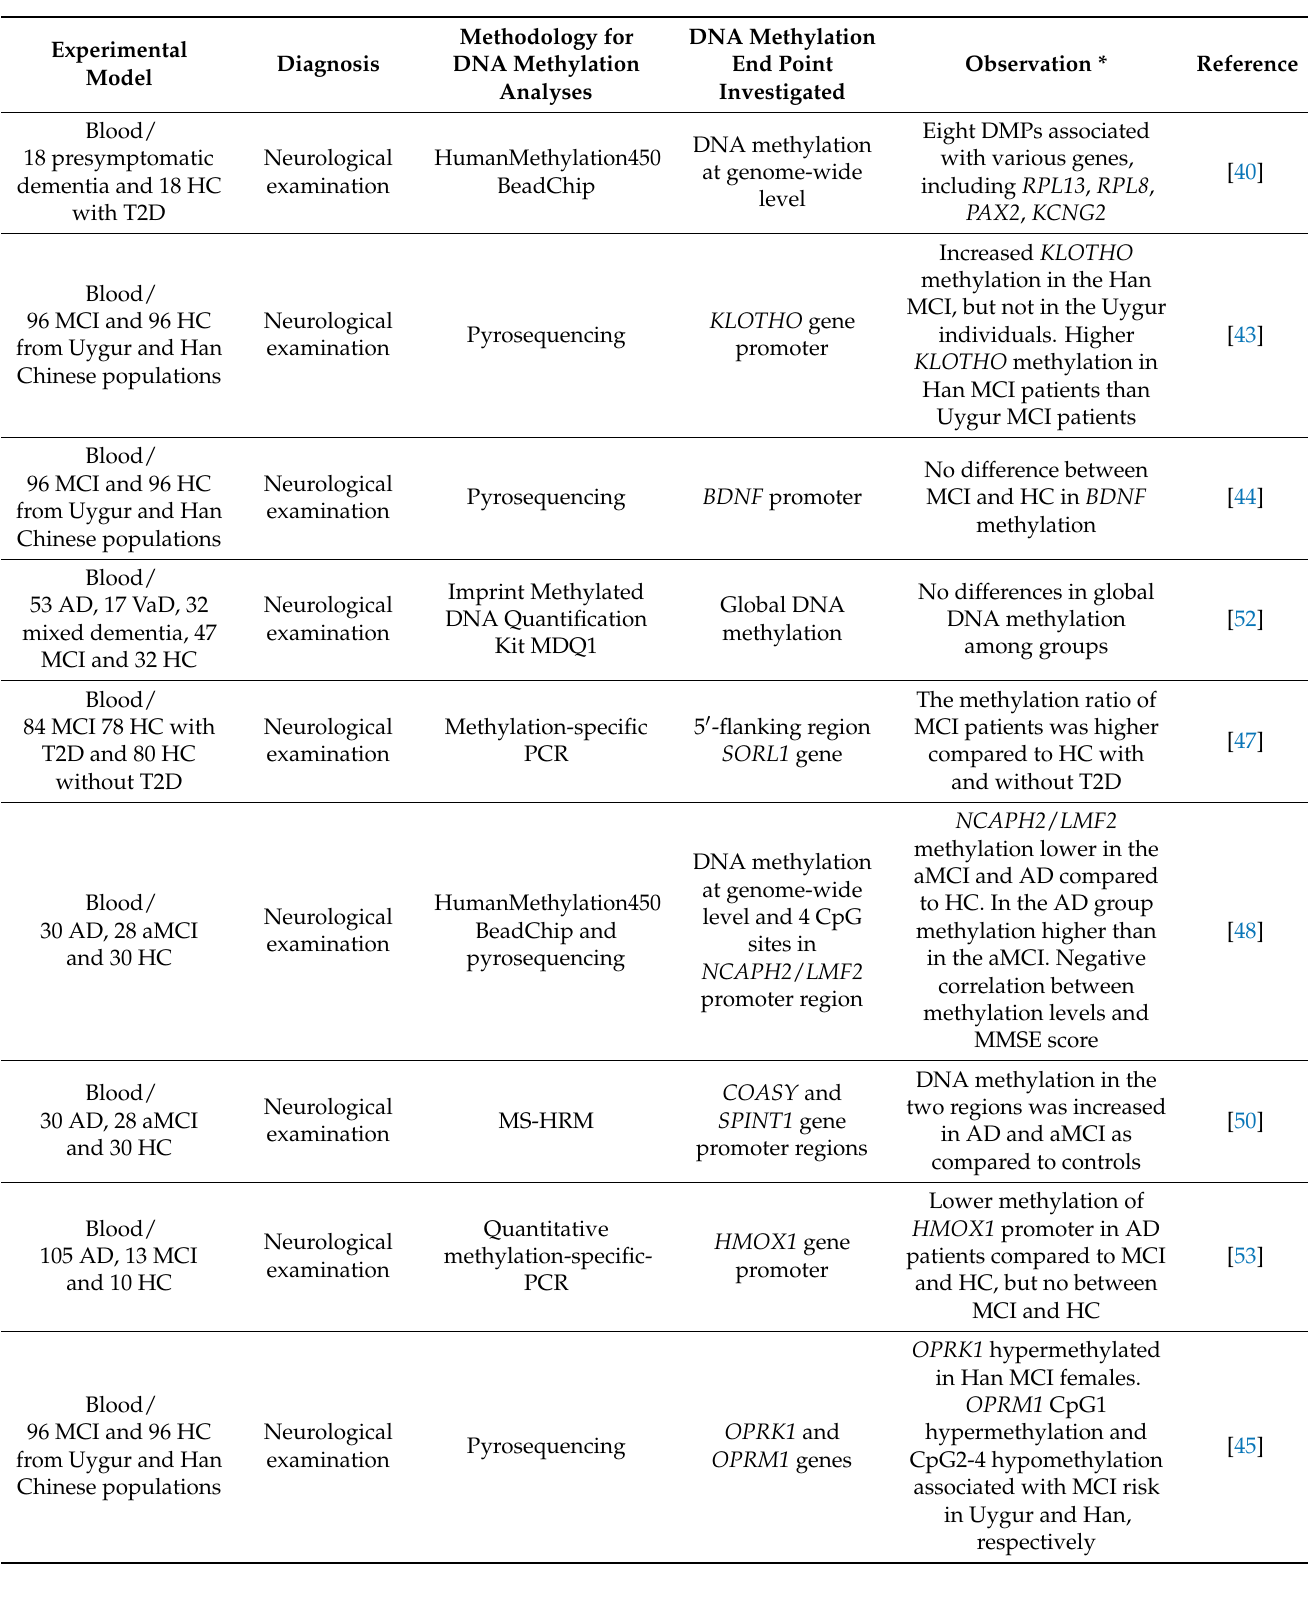
Table 1. Summary of DNA-methylation studies for early detection of